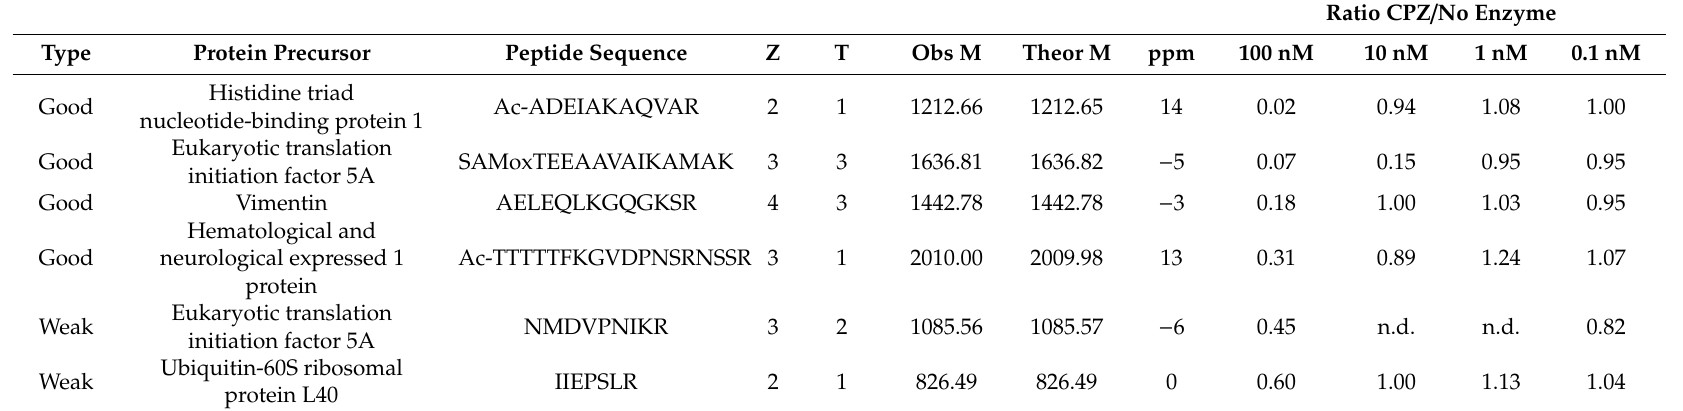
Table 2. Good and weak substrates of CPZ identified using the HEK293T peptide library.